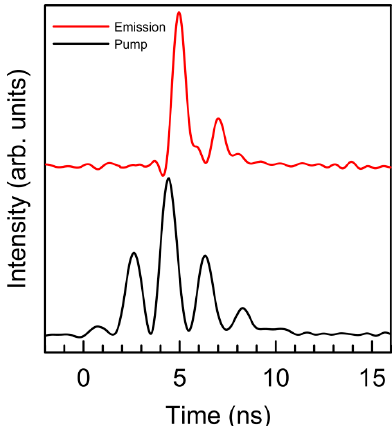
Figure 4. Pump pulse intensity ( black line ) and the corresponding output laser intensity ( red line ), as a function of time.